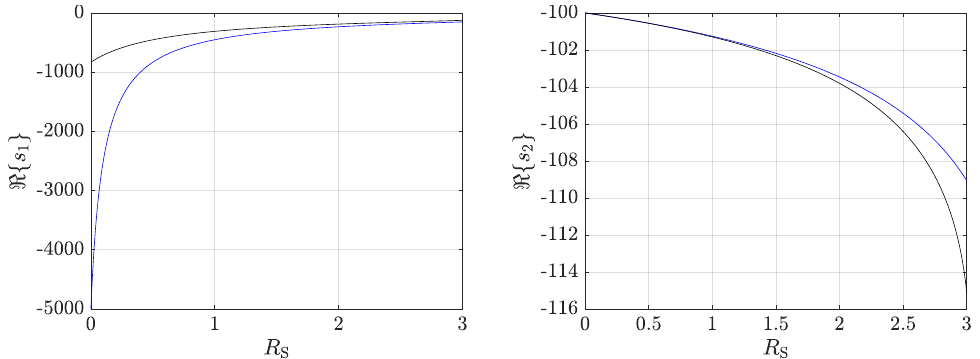
Figure 3. Variability of the purely real eigenvalues in dependence of the load